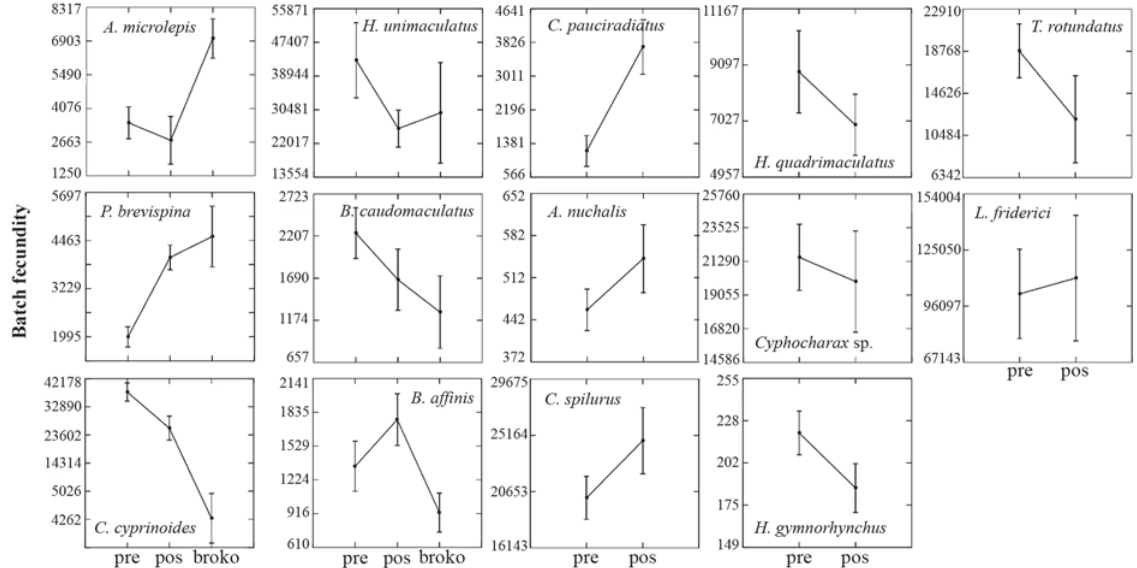
Fig. 5. Comparison of mean batch fecundity of the 14 studied species in the different situations. pre = Sinnamary River 1994- 1996, pos = Petit-Saut Reservoir 2002-2003, broko = Brokopondo Reservoir